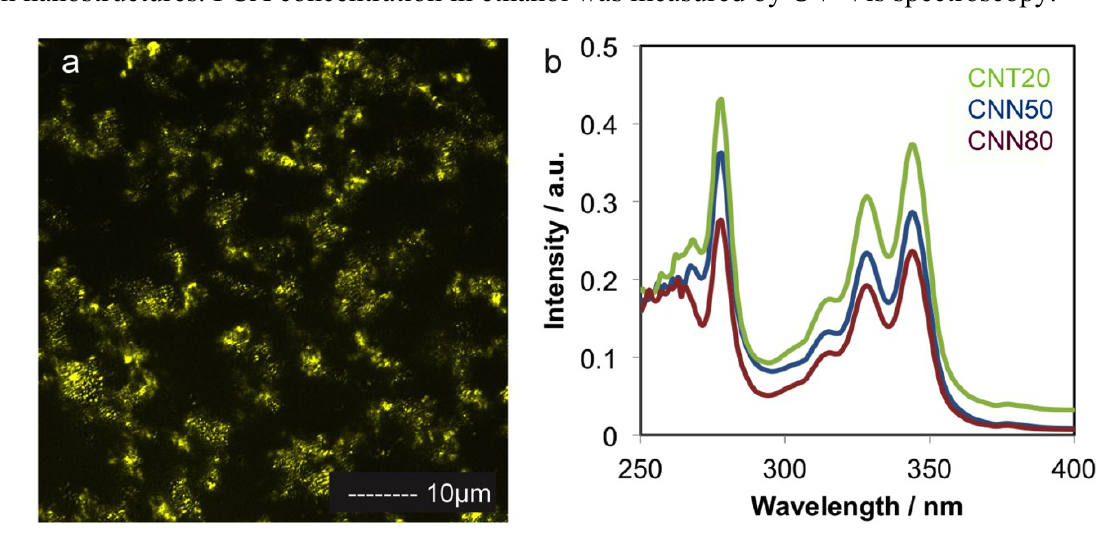
Figure 2. ( a ) Confocal Microscopy image of CNN80 after functionalization; ( b ) UV-Vis spectra of PCA/ethanol collected after functionalization and filtration and diluted 100